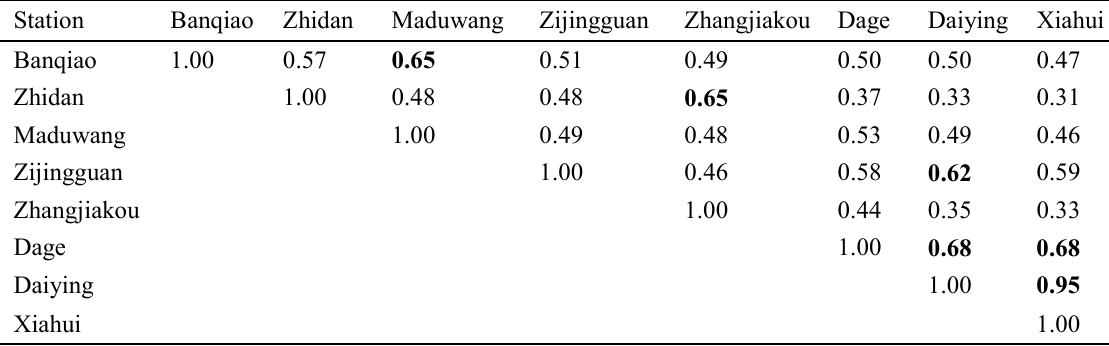
Table 3 Results of catchment physical similarity with each other.